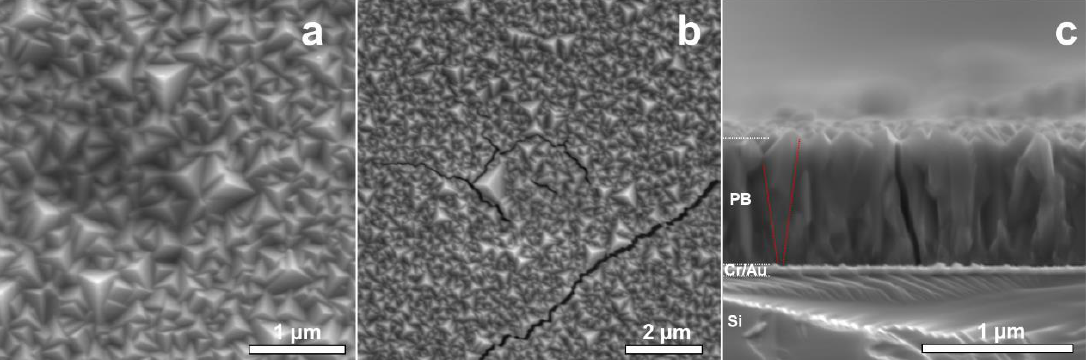
Figure 2. SEM images of the NaFeHCF layer electrodeposited at 0.29 V: ( a ) Surface view of NaFeHCF, ( b ) Crack formation in NaFeHCF layers by electron beam irradiation, ( c ) cross-section view. The red lines in ( c ) mark the change in column size from the top of the film to the bottom.